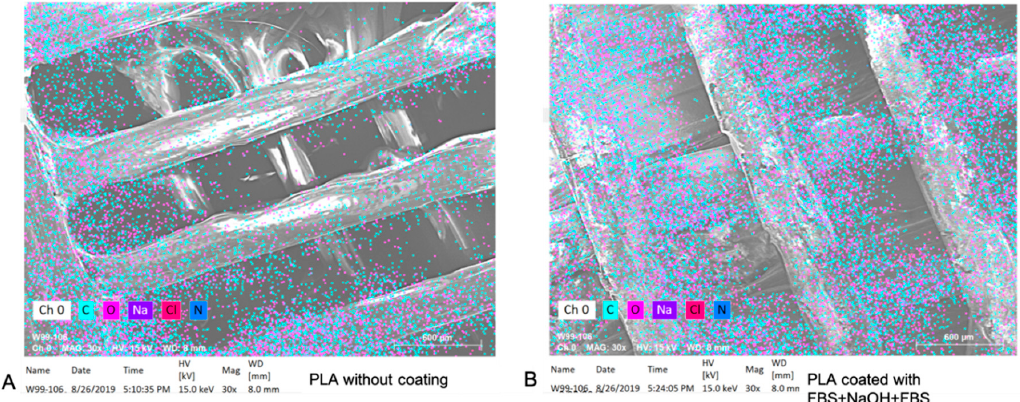
Figure 7. The EDS elemental analysis for PLA square with a naked surface ( A ) and a sandwich-like coating ( B ).